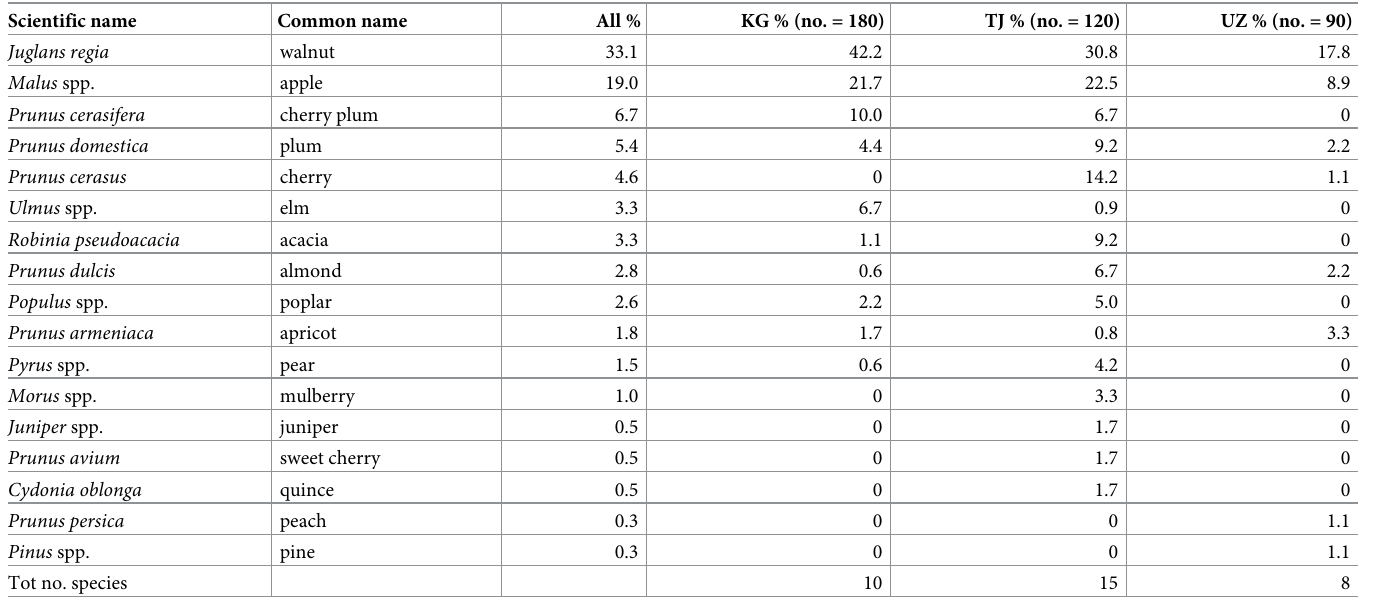
Table 10. Percentage of households per country and overall that plant trees into the forest for each species planted.